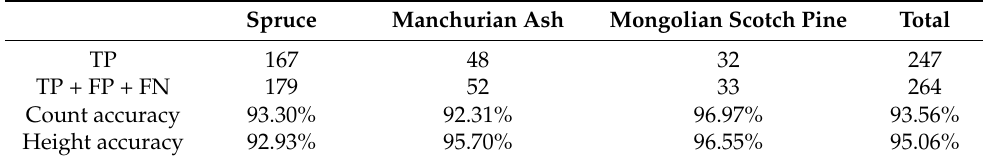
Table 6. Total counting and measuring accuracy.